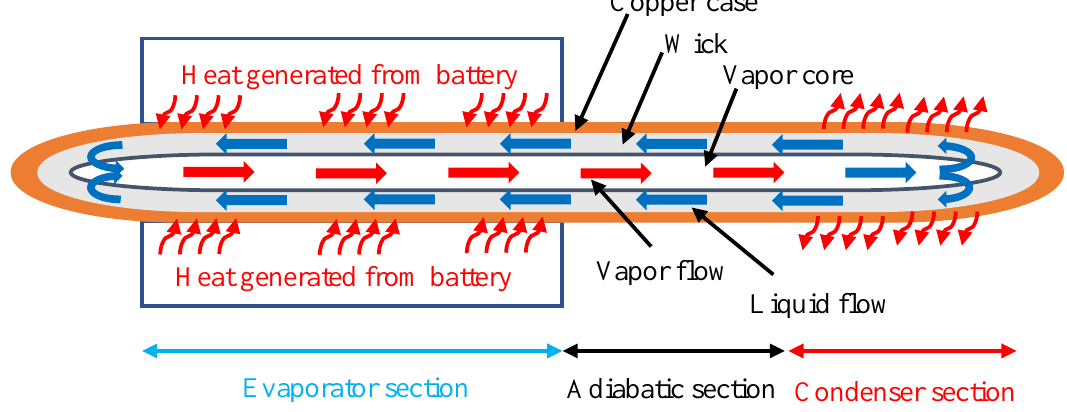
Figure 2. Schematic diagram of a heat pipe. Table 1. Summary of the heat pipe cooling systems reported in the literature.